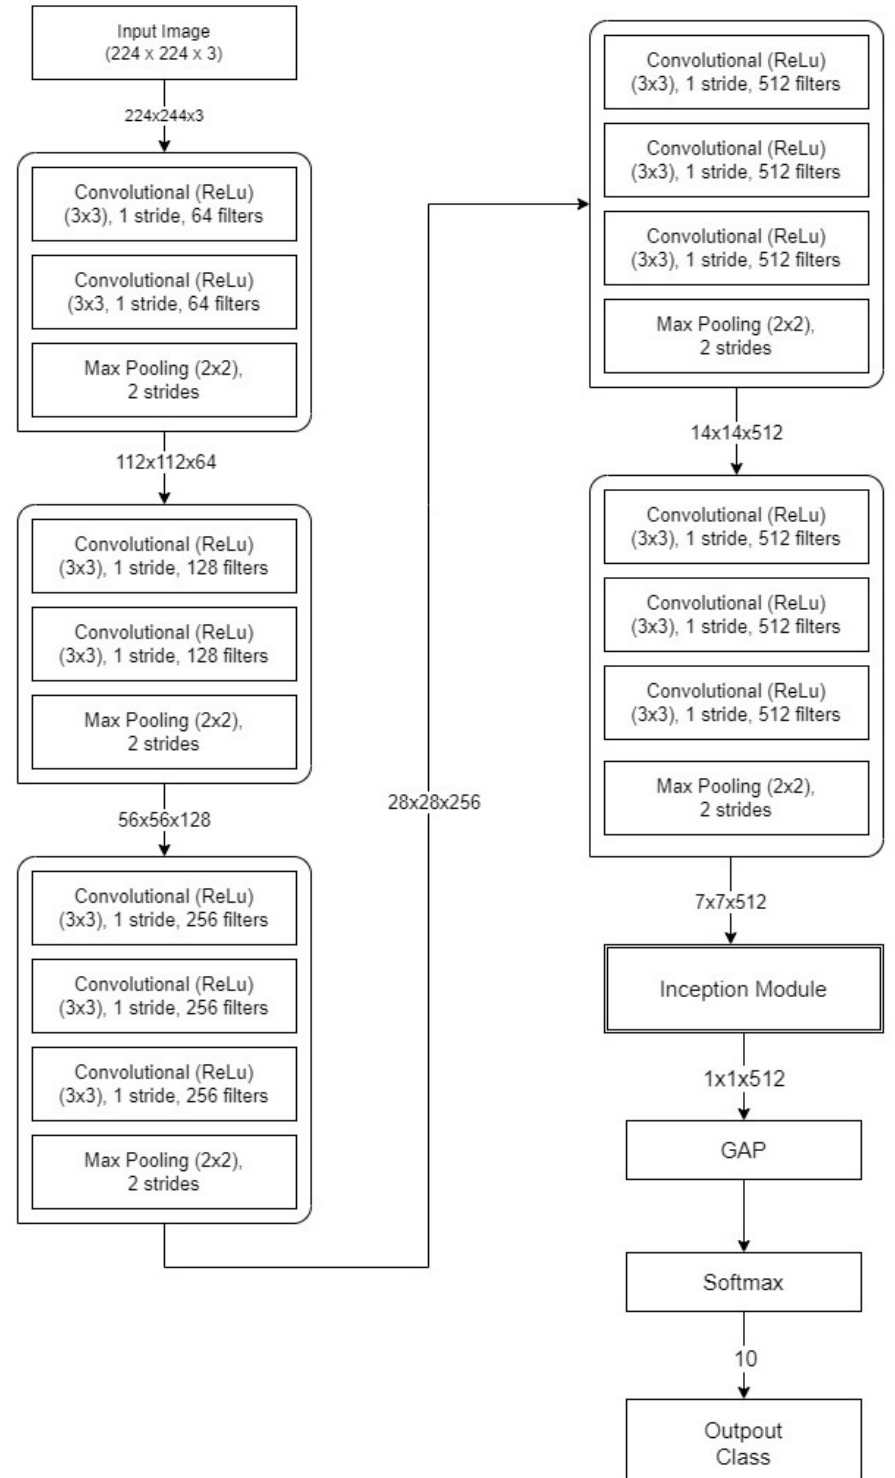
Figure 4. Hybrid CNN model diagram with five VGG blocks, inception module, GAP, and softmax activation function for